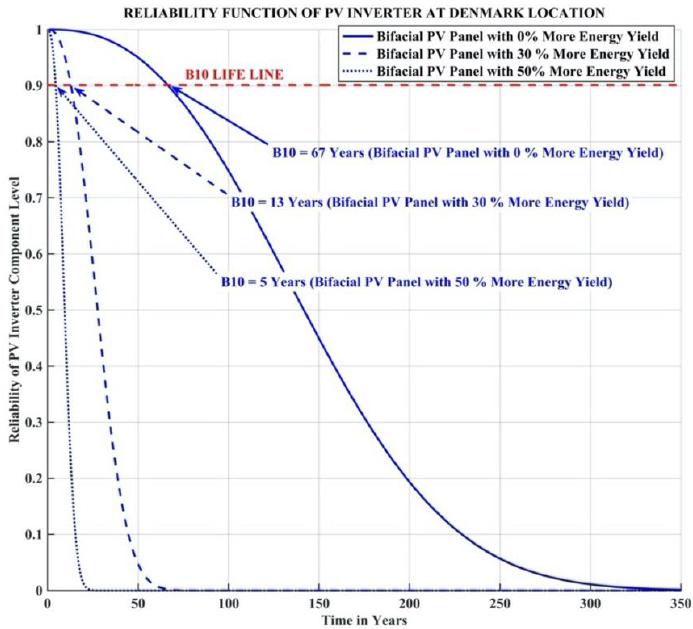
Figure 23. Reliability function of the PV inverter at the location in Denmark (Component Level).